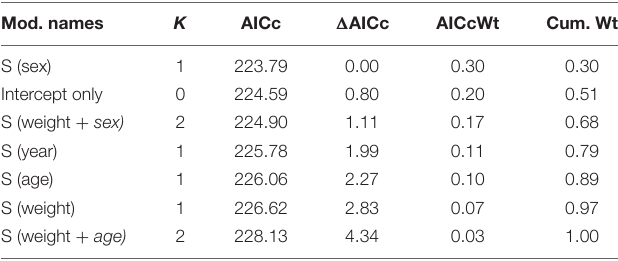
TABLE 1 | Results from cox-proportional hazard models used to test for differences in survival between sex- and age-classes, as well as between